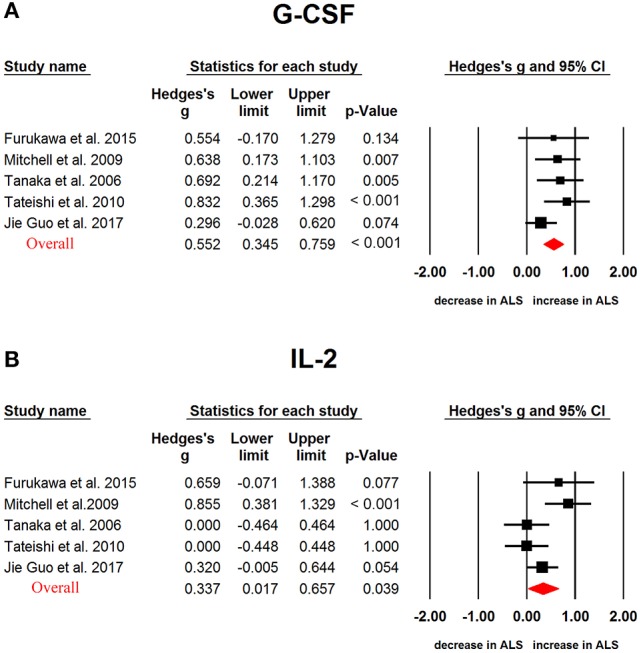
Studies of cerebrospinal fluid G-CSF and IL-2 in Amyotrophic lateral sclerosis. Forest plot displaying random-effects meta-analysis results of the association between G-CSF (A), IL-2 (B) and Amyotrophic lateral sclerosis. The sizes of the squares are proportional to study weights.